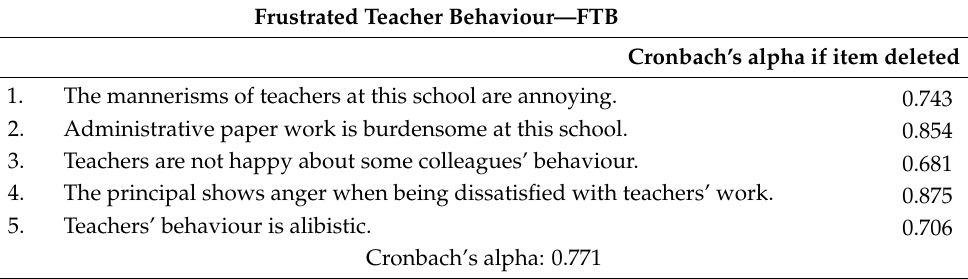
Table 6. Frustrated teacher behaviour FTB—Cronbach’s alpha for internal consistency.